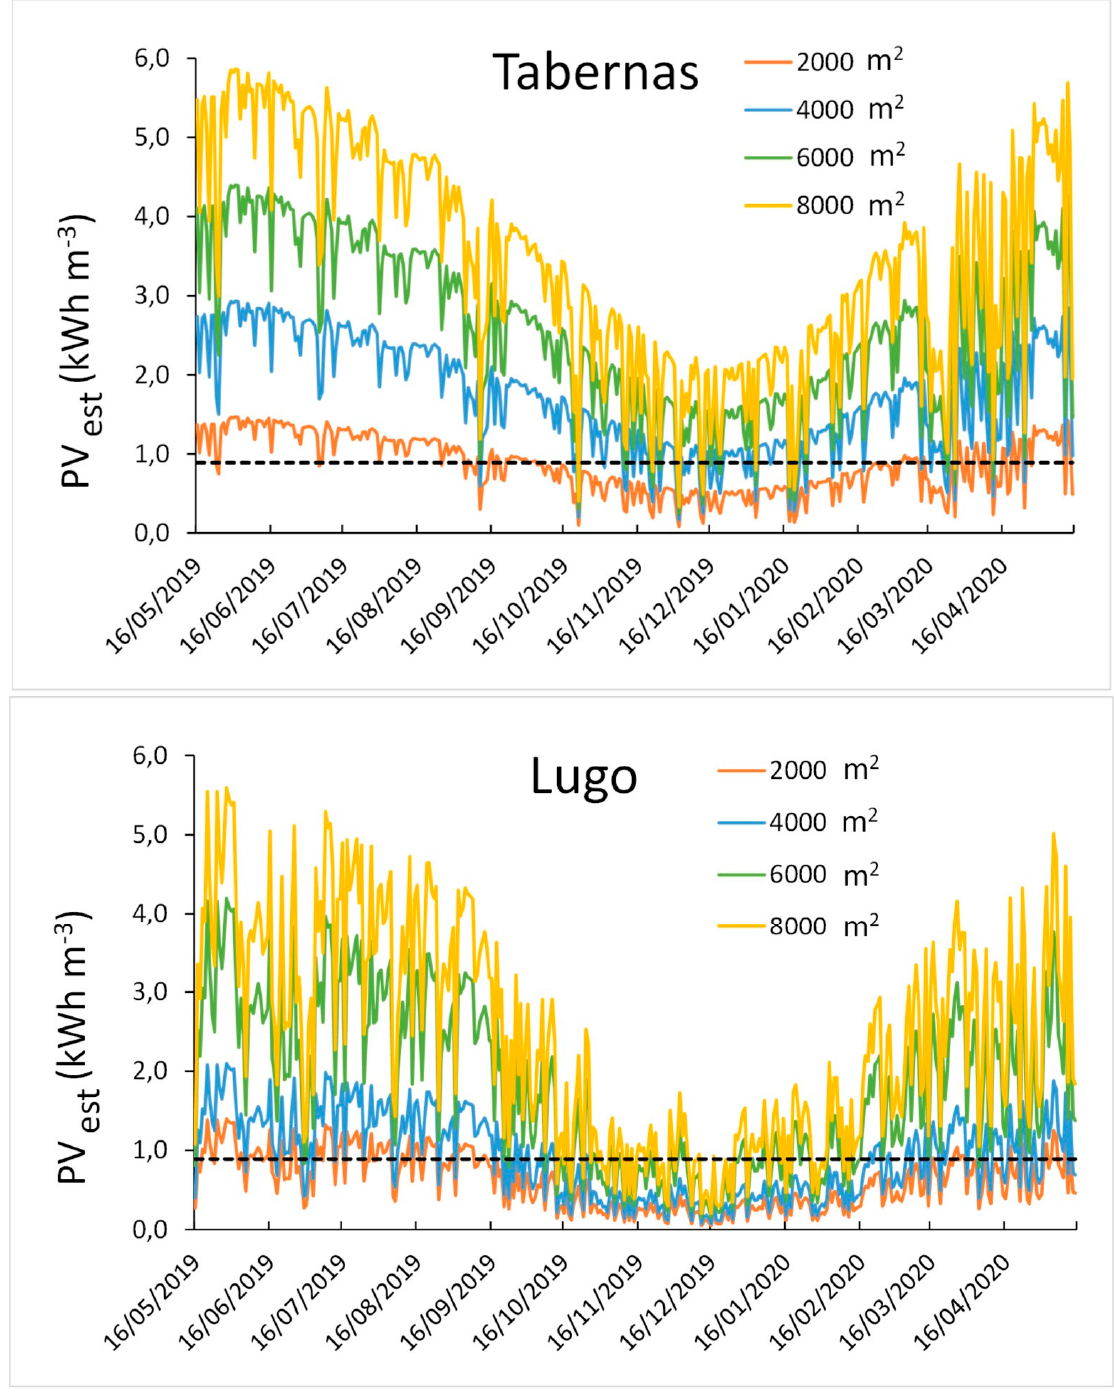
Figure 2. PV power for different areas; the energy consumption threshold (0.89 kWh m − 3 ) is included.